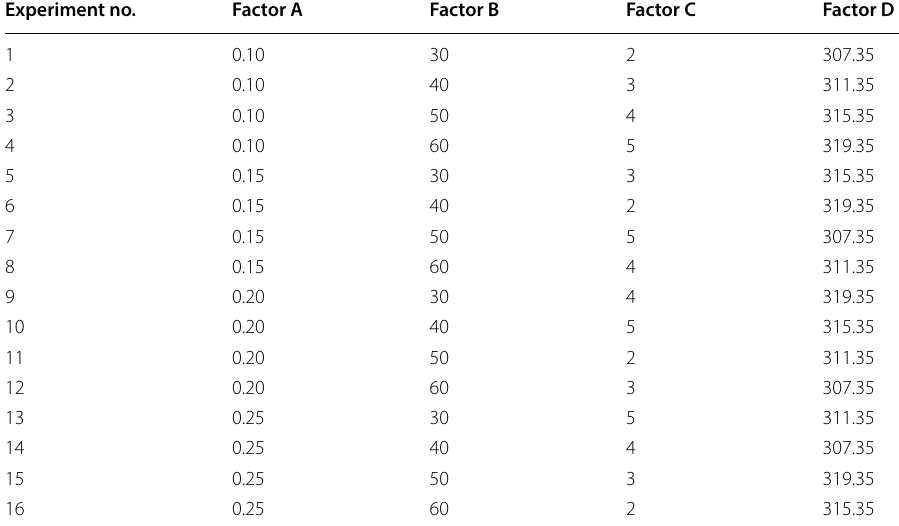
Table 3 Taguchi L16 orthogonal array Experiment